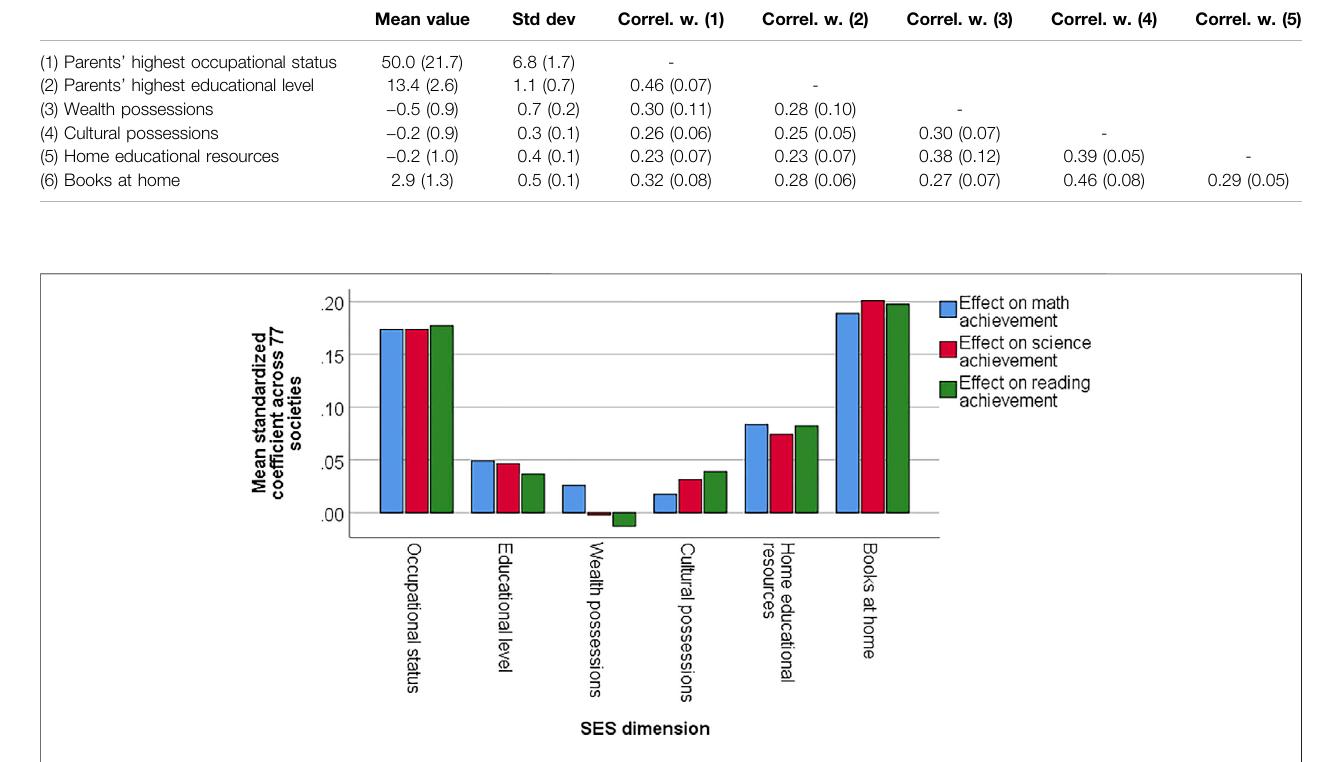
FIGURE1| EstimatesoftheindependenteffectsonachievementofsixSEScomponents.Barsshowmeanvaluesofstandardizedcoef fi cientsacross77societies. Different colors denote different achievement domains: math (blue), science (red), and reading